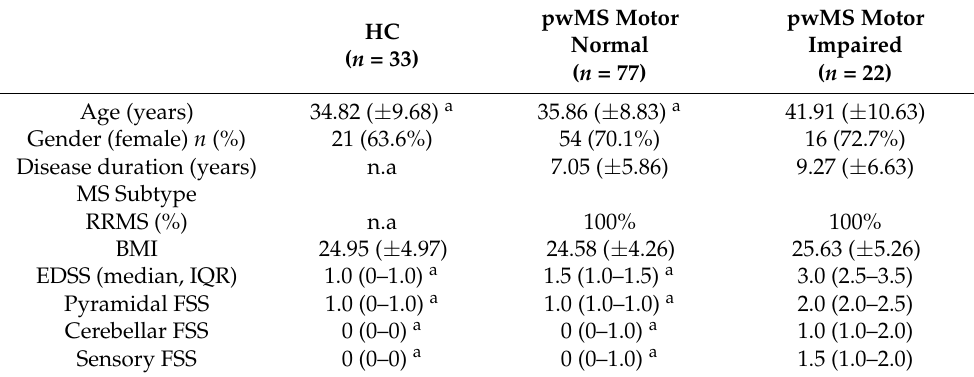
Table 2. Baseline characteristics of the study population. Data presented as mean ( ± standard deviation) unless specified otherwise.